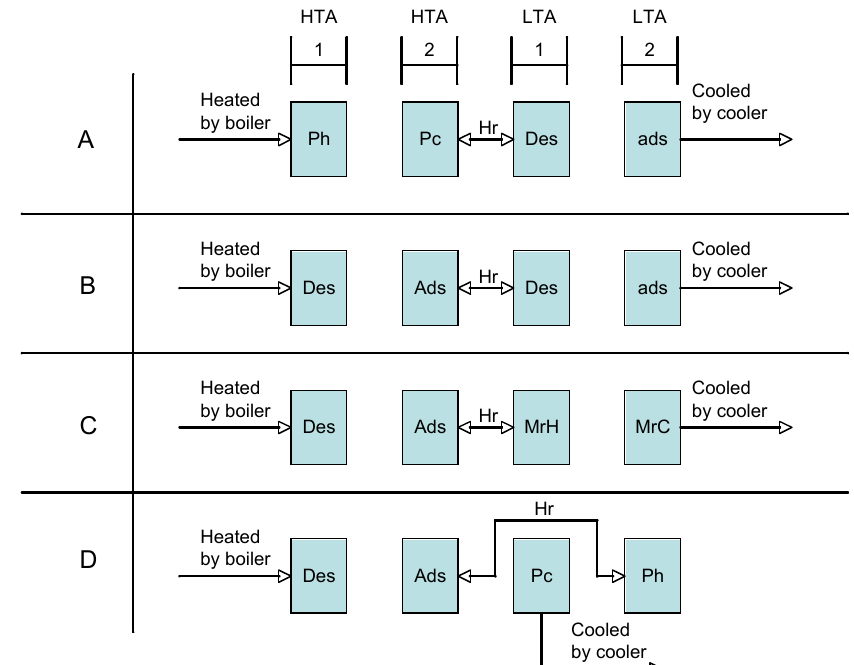
Figure 5. Schematic of heat flow of the proposed cascading cycle with mass recovery on half